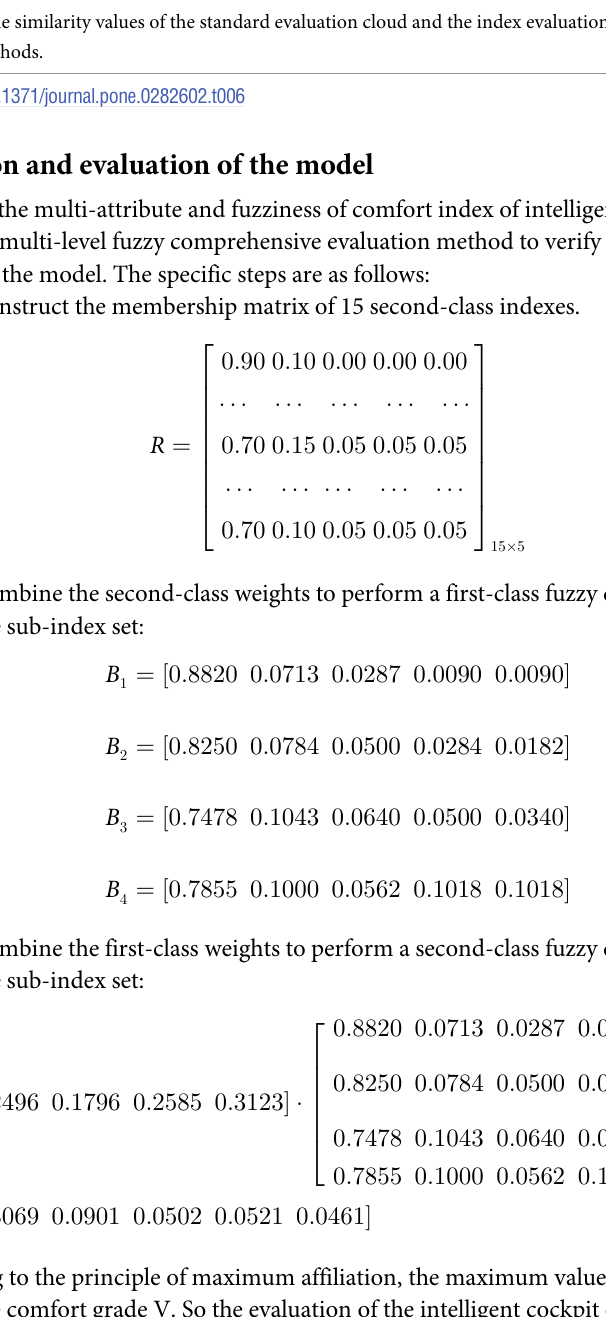
Table 6 shows the similarity values of the standard evaluation cloud and the index evaluation cloud calculated based on the three